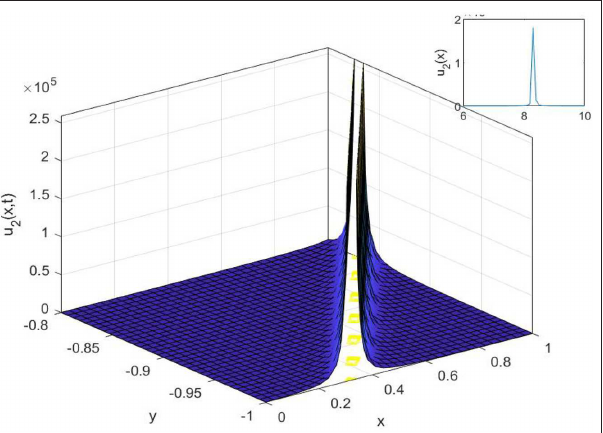
FIGURE 2 | The 3D, 2D, and contour surfaces of Equation (21) using h 4, k 0.5, α 2.6, µ 0.2, ǫ 4, and C 1 = = = = =